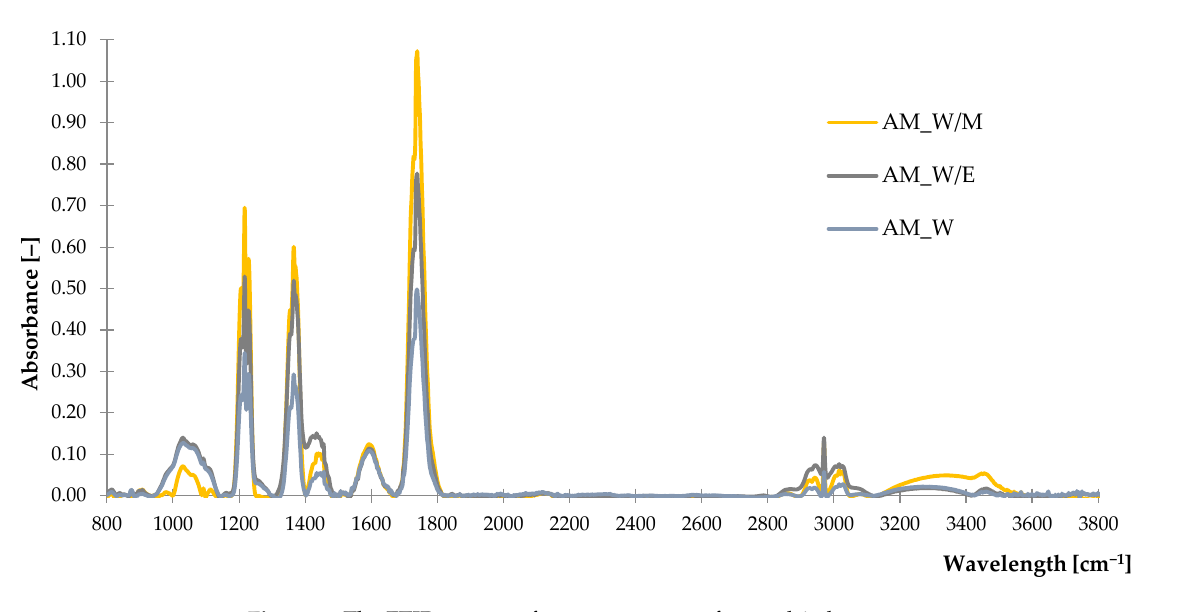
Figure 1. The FTIR spectra of German chamomile freeze-dried extracts.